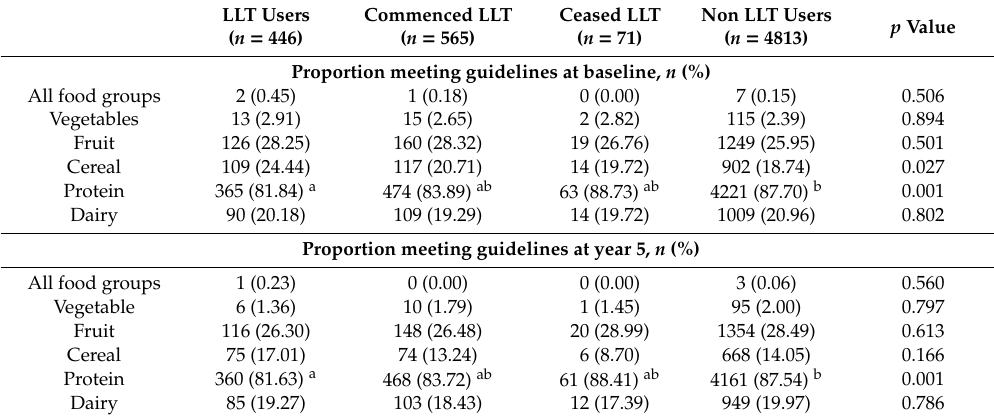
Table 2. Baseline characteristics of study population by lipid-lowering therapy group.